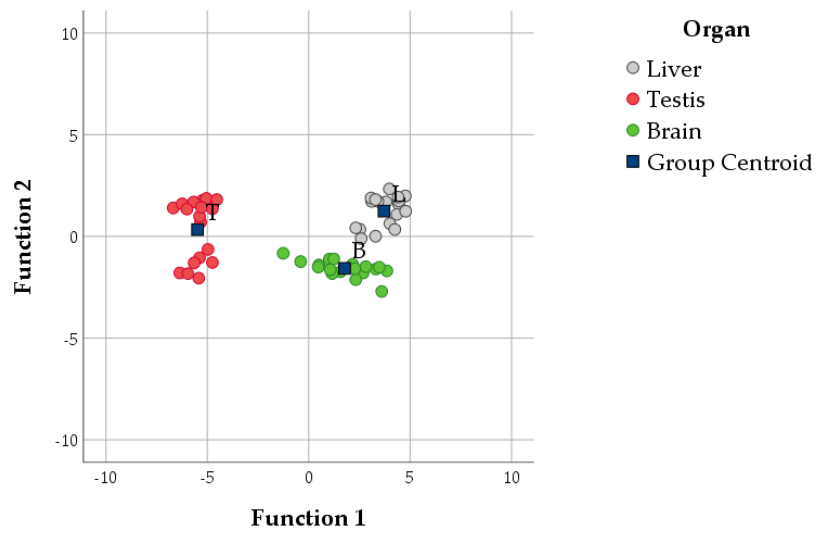
Figure 8. Scatterplot of canonical discrimination analysis (DA) including variables indicating the lipid and isoprostanoid profile (DA2) with the centroids of each organ (blue squares). L, liver; T, testis; B, brain.